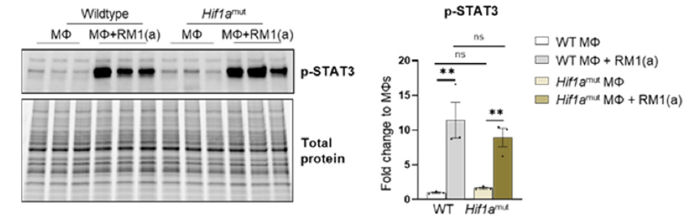
Figure A9. STAT3 phosphorylation in efferocytic Wildtype (WT) and Hif1a mut BM macrophages. BM macrophages (M Φ ) were isolated from 4 wk old Hif1a flox/flox (WT), Hif1a mut mice and co-cultured with apoptotic RM1cells (RM1(a)) for 16–18 h. Cell lysates from efferocytic and non-efferocytic macrophages were analyzed by Western blot using p-STAT3 antibody. Graph shows p-STAT3 fold change in efferocytic BM macrophages from WT and Hif1a mut mice relative to controls (M Φ s alone). ** p < 0.01, ns = not significant (ordinary one-way ANOVA; Tukey’s multiple comparison